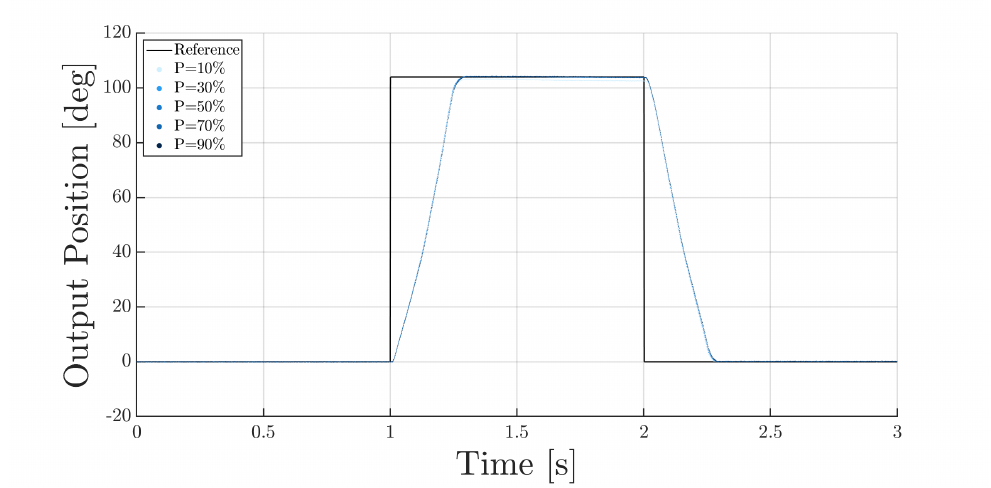
Figure 12. Position step responses for different spring pre-compression levels in no-load